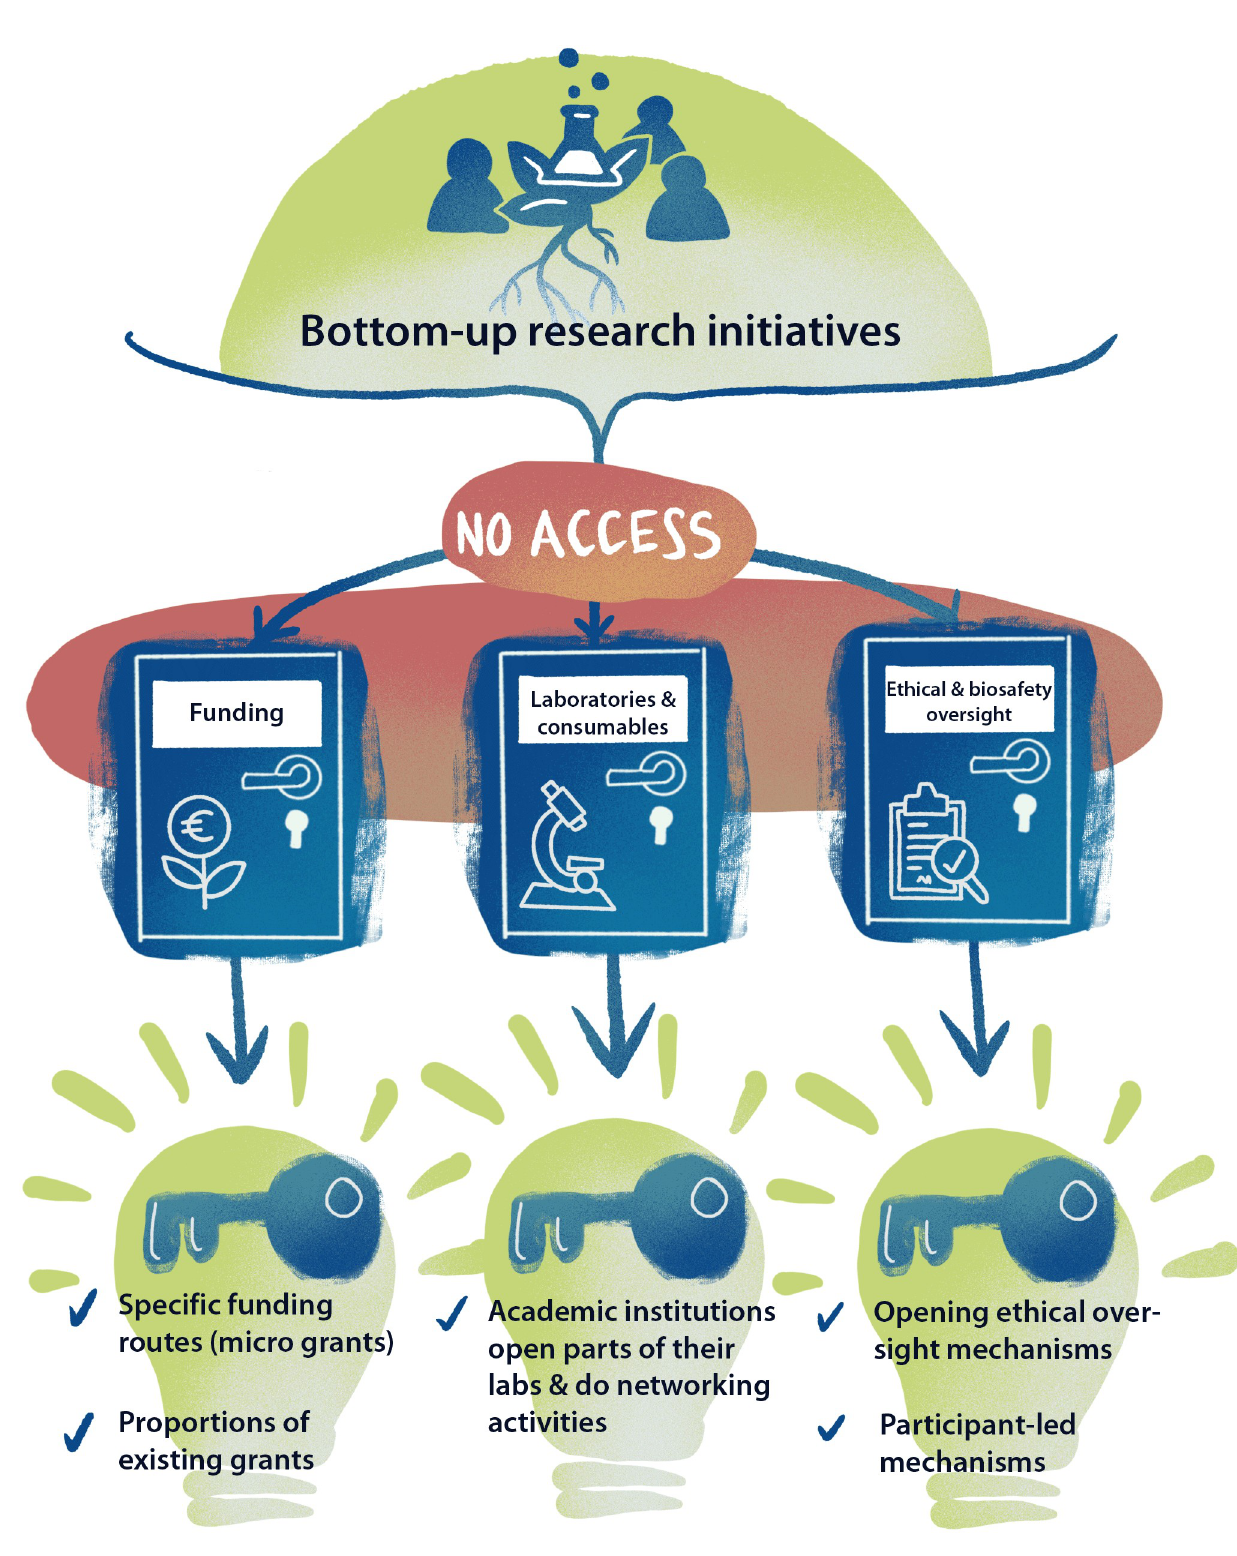
Fig 1. Barriers and solutions for bottom-up research initiatives. We identify 3 types of barriers: access to funding, access to laboratories and consumables, and access to ethical and biosafety oversight. For each, we offer actionable solutions.